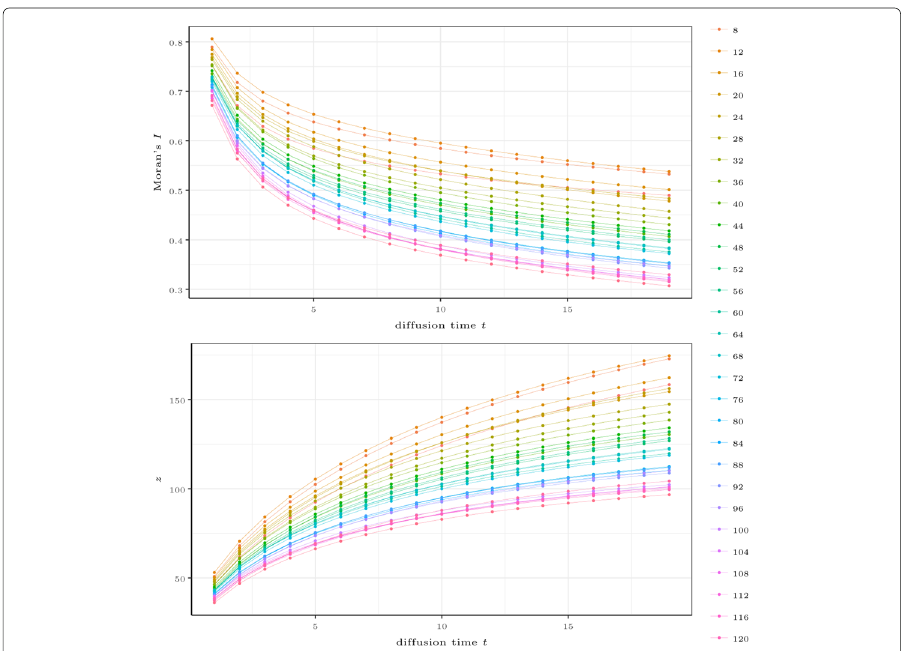
Fig. 4 The figures represent Moran’sI ( upper ) and z ( bottom ) trough the exchange matrix diffusion process at time t = 1, ... ,20 using various distances extracted from topic models having k = 8,12, ... ,120